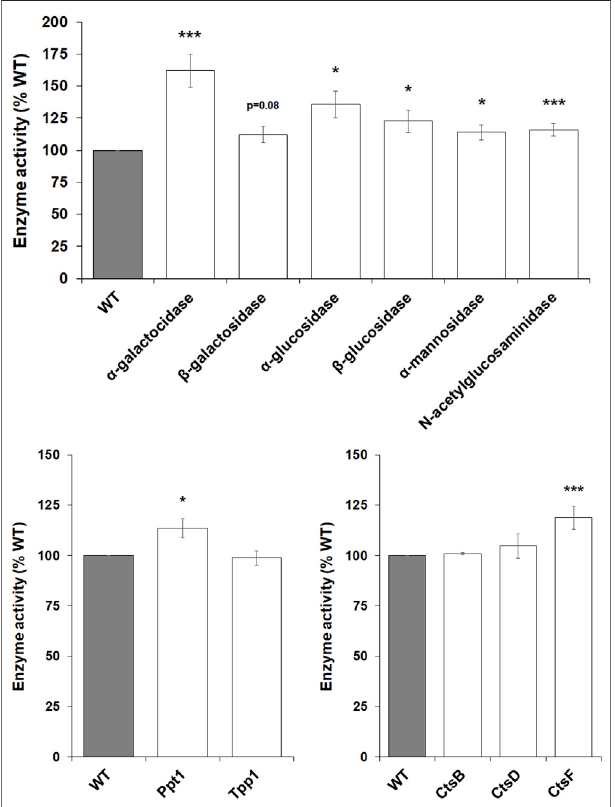
FIGURE 5 | Effect of mfsd8 -de fi ciency on aggregation. (A) WT and mfsd8 − cells grown axenically in HL5 were submerged in KK2 buffer and imaged at the indicated time points. Scale bars = 250 μ m. Images are representative of six independent experiments. (B) WT and mfsd8 − cells grown axenically in HL5 were harvested, washed with KK2 buffer, and deposited onto 0.5% agar/KK2. Images were taken once cells were deposited and after 5 h. Scale bar = 250 μ m. The amount of aggregation of each cell line was quanti fi ed by measuring the area of the cell spot that remained after 5 h of starvation, subtracting it from the initial area, and then expressing the difference as a percentage of the area of the cell spot at 0 h. Data presented as mean % aggregation ± SEM ( n = 9). Statistical signi fi cance was assessed using the Kruskal-Wallis test followed by the Dunn ’ s multiple comparisons test. ** p <